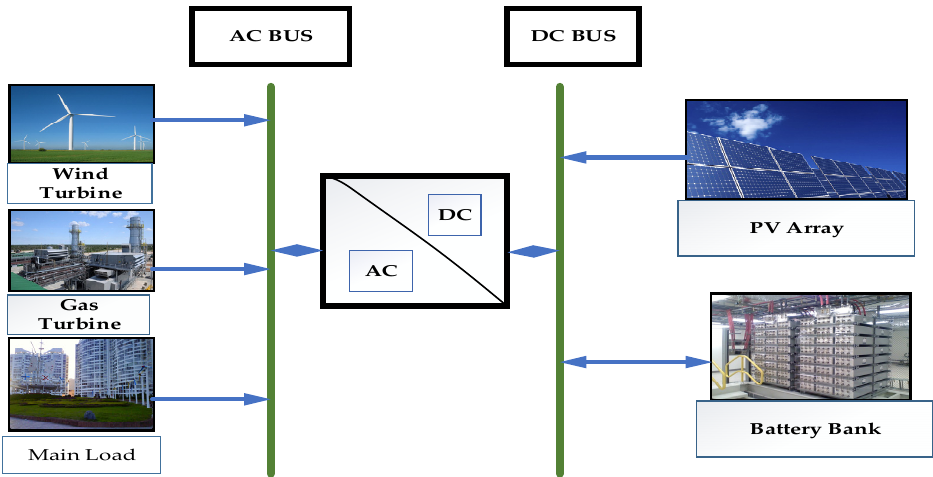
Figure 6. Schematic diagram of hybrid wind/PV/GT/battery storage.